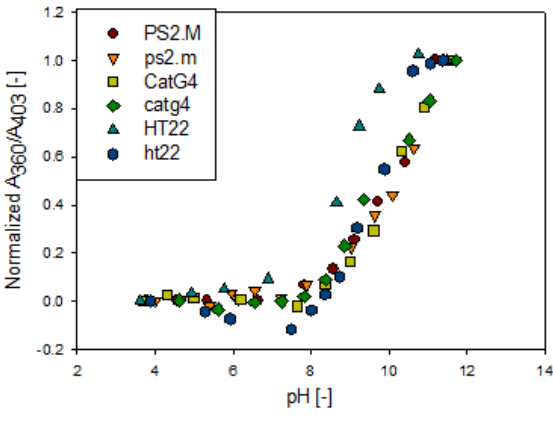
Figure 3: Determination of pKa of studied G-quadruplex/hemin complexes. Conditions: 10 mM Tris-HCl, 100 mM KCl,